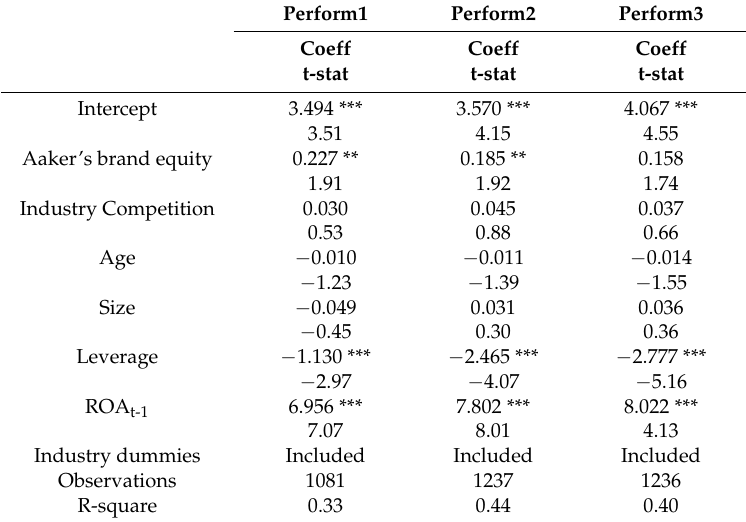
Table 7. Sensitivity analyses. Alternative definitions of